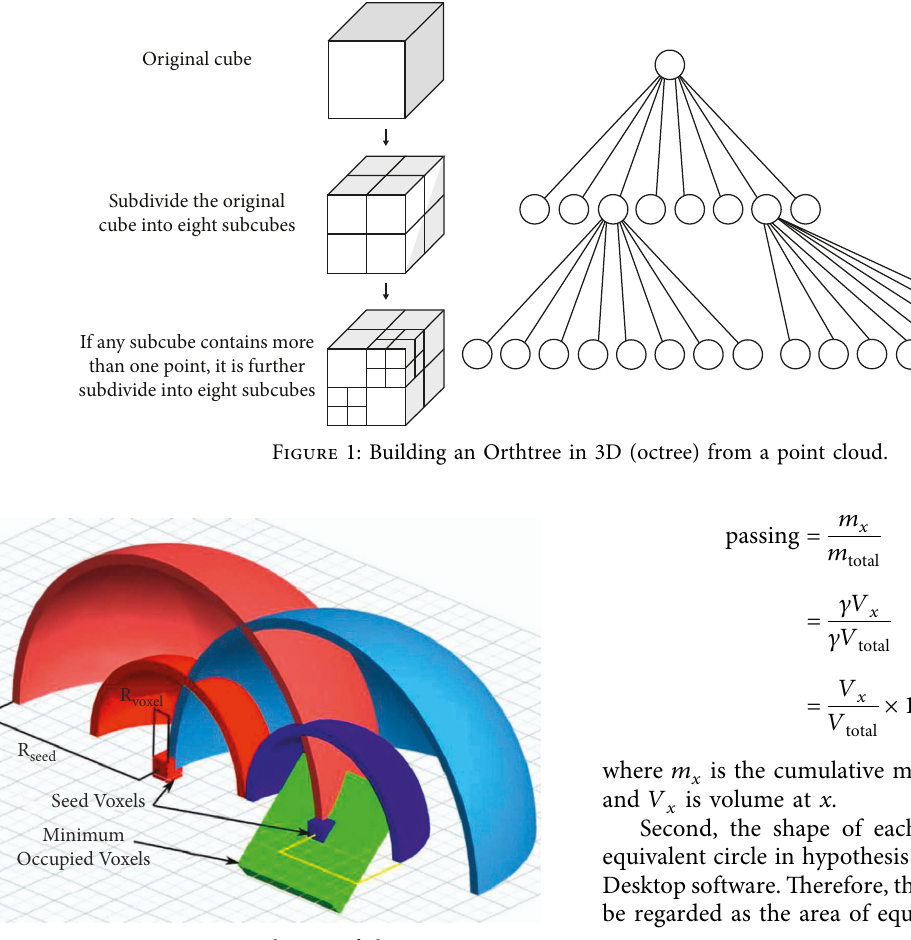
Figure 2: Geometric relations of